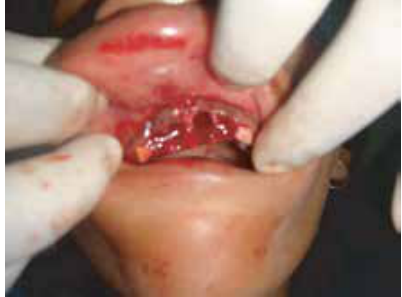
Fig 1. Absence of central and lateral incisors